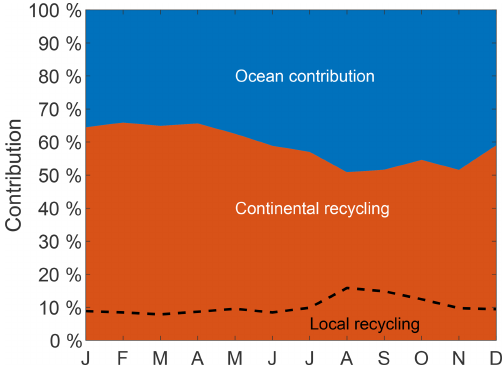
Figure 6. Fraction of land and ocean contribution to YRV precipi- tation. Local recycling is shown with a dashed line and is a subset of continental